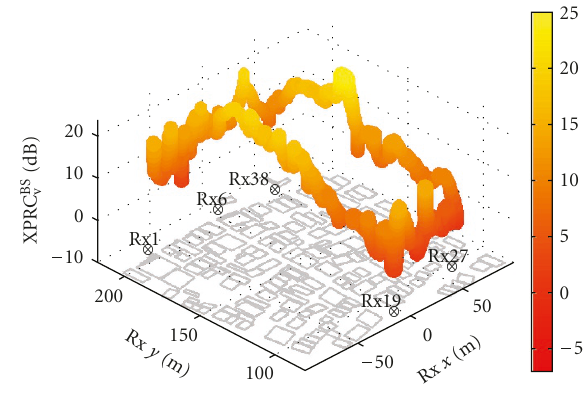
of the SCs Δ s = 20 (ca 3m). h